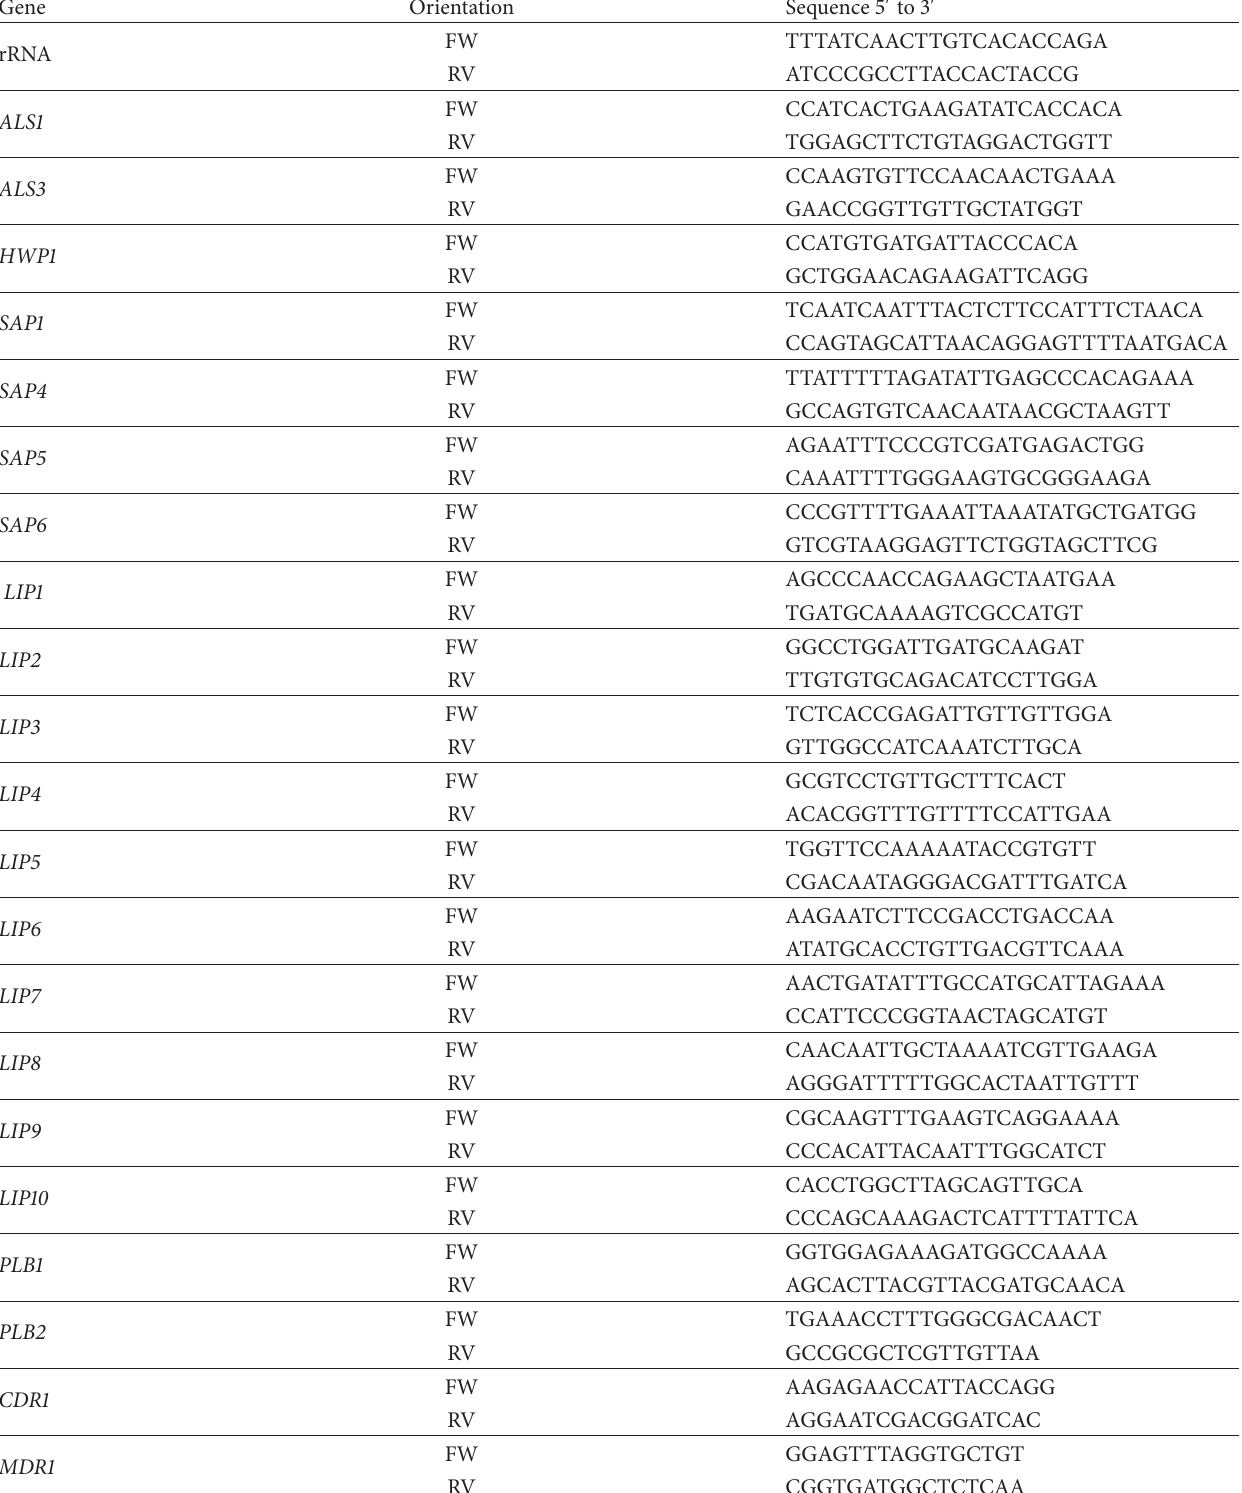
Table 1: Primers used in PCR and real-time PCR assays